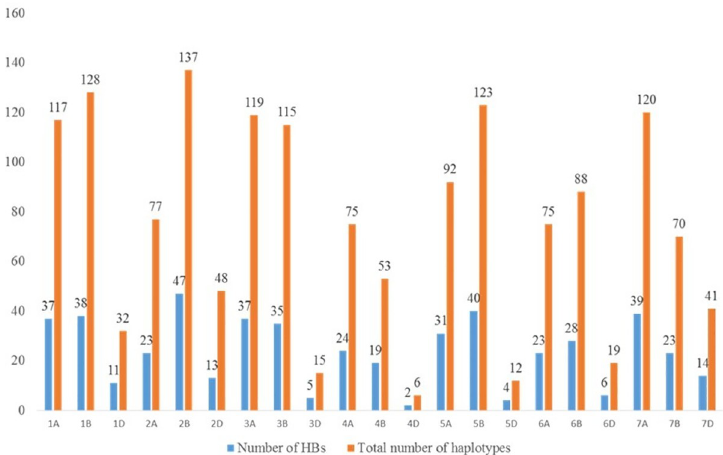
Fig 6. Genome-wide distribution of haplotype blocks and haplotypes. Graph confirms that number of haplotype blocks and haplotypes are highest in ‘B’ genome followed by ‘A’ and least in ‘D’.